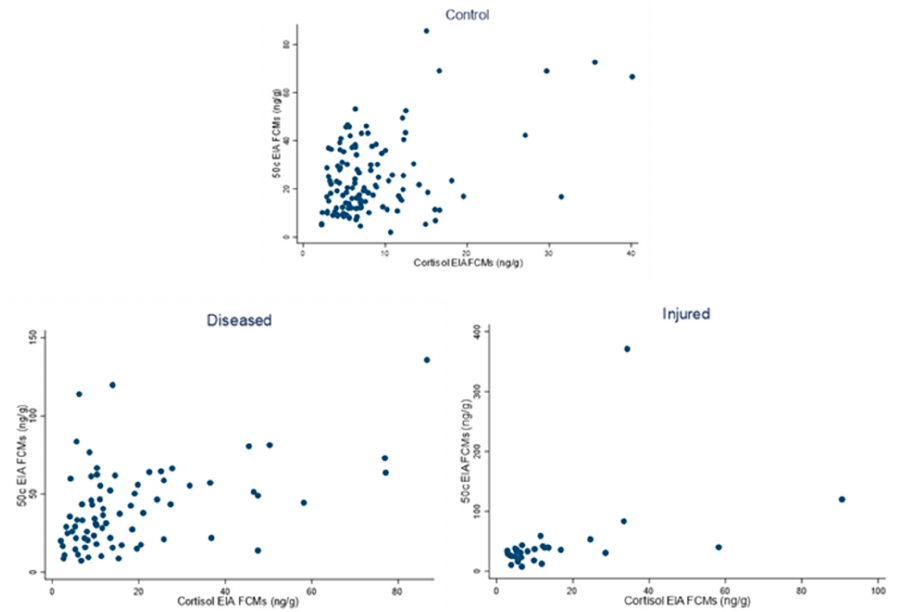
Figure 5. Scatterplots correlating FCM (faecal cortisol metabolite) values of the control (N = 124), diseased (N = 76) and injured (N = 30) koalas, measured with the 50c and cortisol EIAs (enzyme immunoassays).